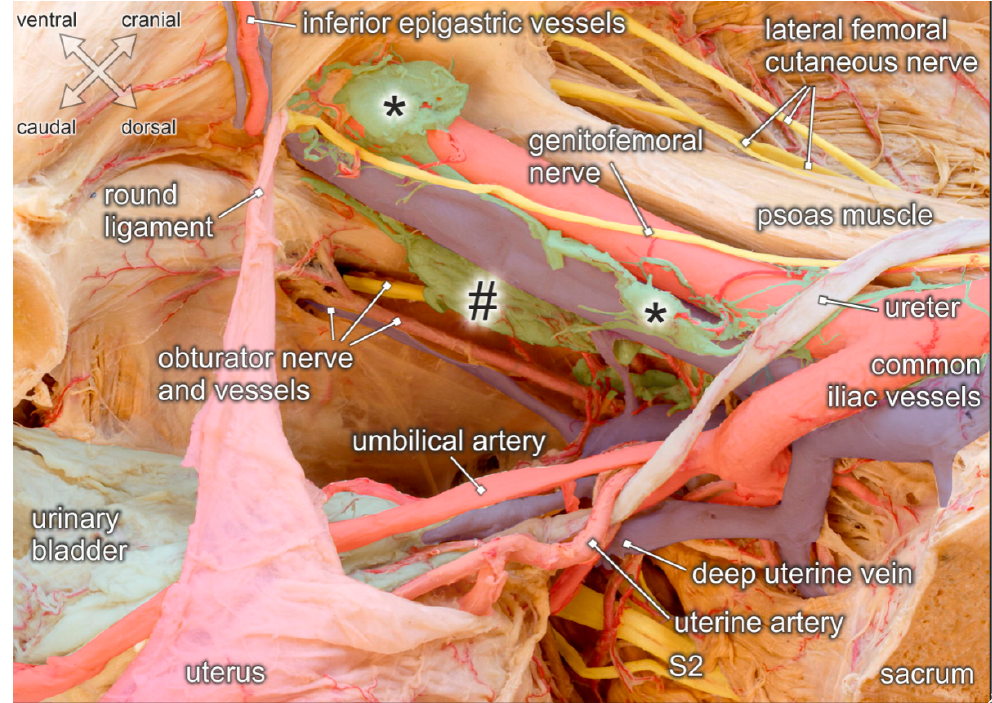
Figure 5. Topographic anatomy of the pelvic sidewall. Medial view of a right female hemipelvis. The bladder and uterus are shifted to the left side; fascia and parametric tissue are removed. Distal and proximal external iliac lymph nodes (asterisks), obturatory lymph nodes (hashtag) and interconnecting lymphatic vessels are exposed. Structures at risk during lymphonodectomy are the genitofemoral nerve running across the external iliac vessels, the obturator nerve and vessels extending throughout the obturator fossa, and the ureter crossing the proximal external iliac vessels. While both, the umbilical and uterine artery are undercrossed by the ureter, the deep uterine vein runs beneath the ureter.